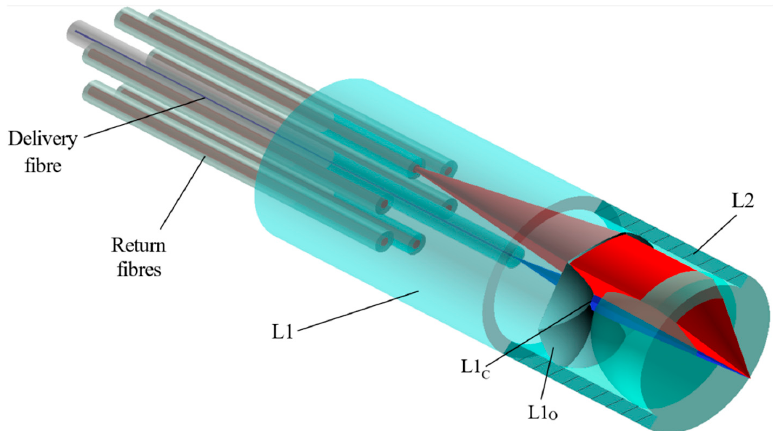
Figure 1. A partial cut-away rendering of the proposed distal-end optical system (DOS) for the laser- written Raman probe. The optical system consists of two components, L1 and L2, which interface with one light delivery and six light return optical fibres. Excitation light (represented in blue) is delivered by a central fibre and focused beyond the tip of the probe. Raman-scattered light (one sixth shown only—represented in red) is collected by the DOS and coupled back into the six return fibres for analysis.